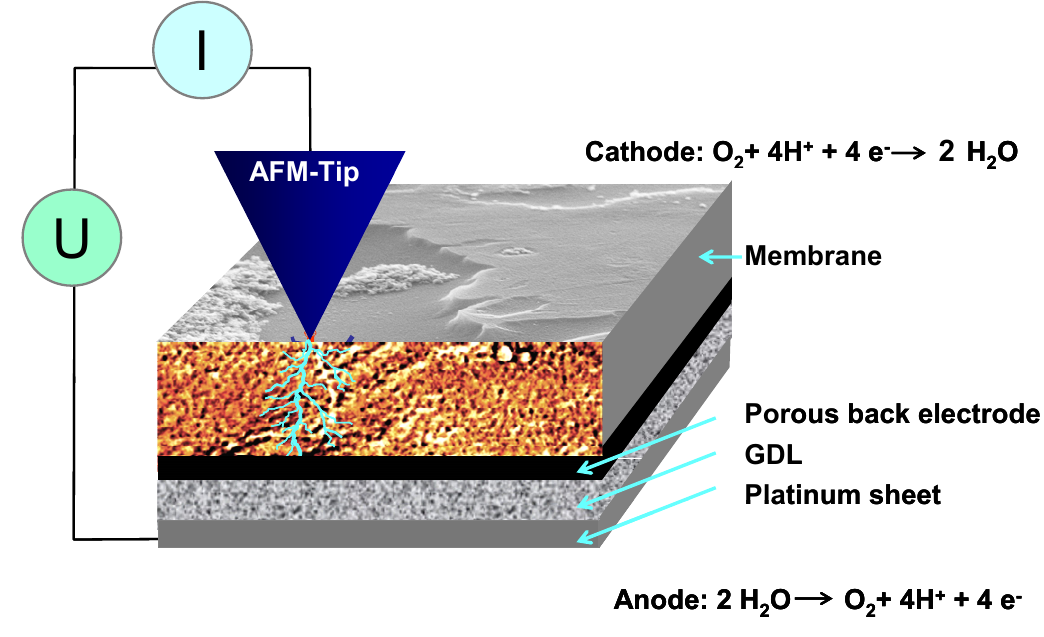
Figure 2. Schematic drawing of a conductive atomic force microscopy (AFM) measurement at an ionically conductive membrane in an ambient humid environment: Ionic current through the membrane results from two electrochemical reactions at the extended back electrode and the platinum-coated AFM